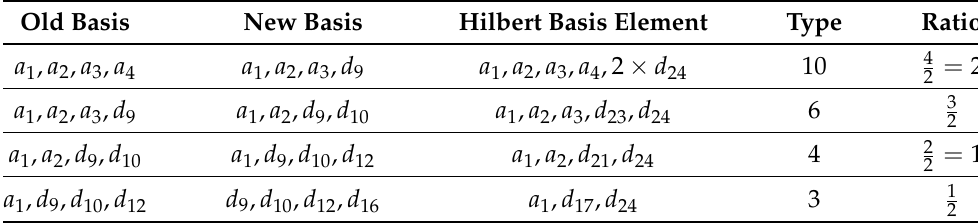
Table 3. The relation of the elements of the Hilbert basis and the changes of